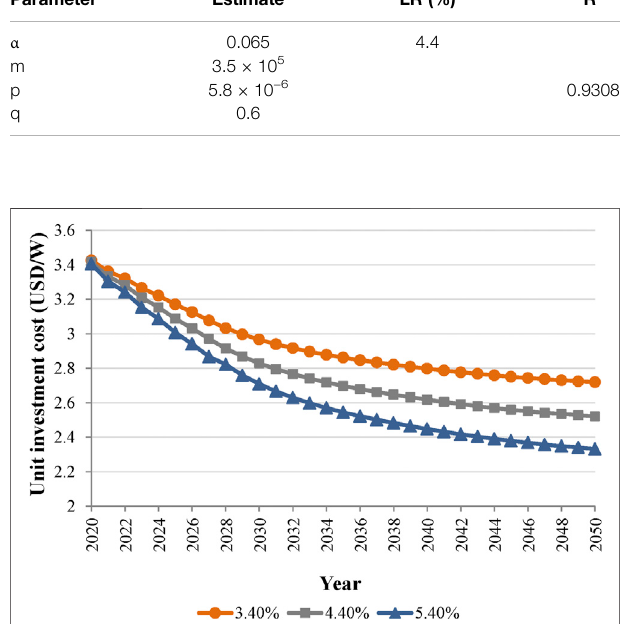
FIGURE 3 | Unit investment cost changes under different learning rates.